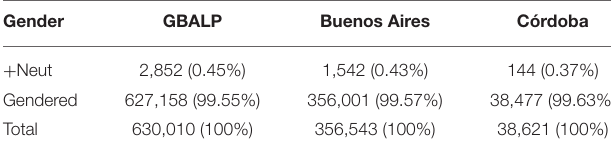
TABLE 1 | Frequency of tokens representing ± neut. gender in all three